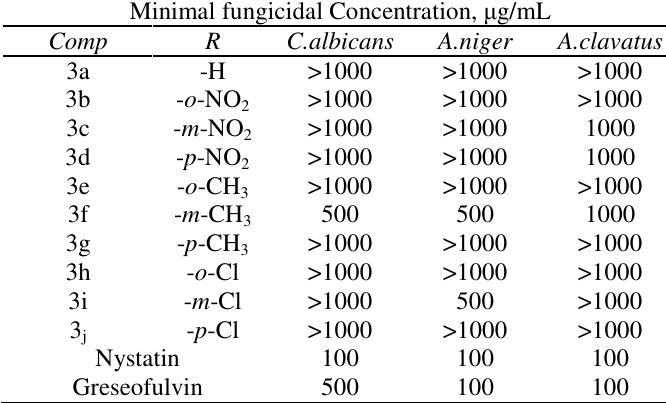
Table 3 . Antifungal activity of synthesized compounds 3a to